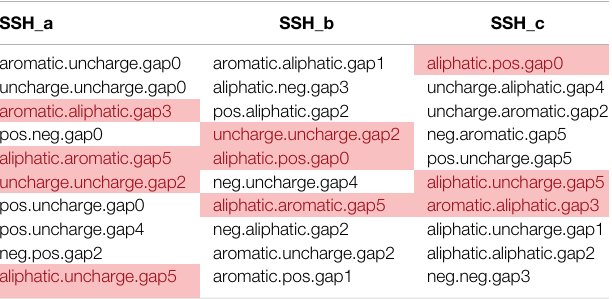
TABLE 3 | The prediction performance of the ensemble model based on 20 feature extraction algorithms. Feature